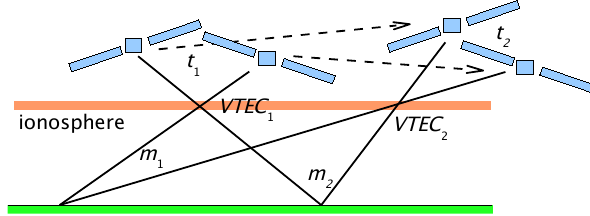
Fig. 6. Situation where TEC calibration is